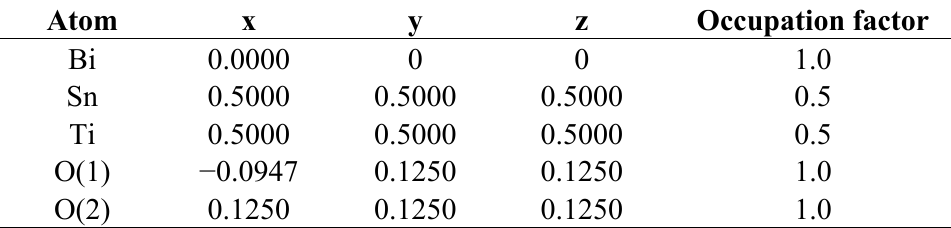
Table 1. Atomic coordinates and structural parameters of Bi state reaction